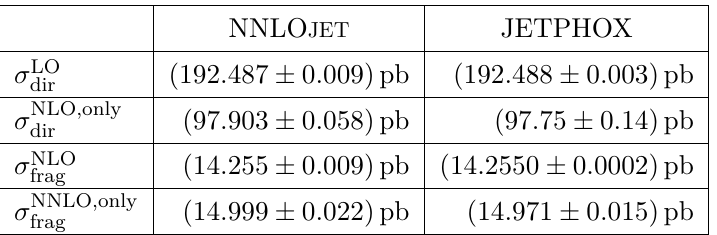
Table 1. Comparison of direct and fragmentation contributions to the photon-plus-jet cross section obtained with NNLO JET and JETPHOX. The ‘only’ numbers indicate the increment from the coefficient at the respective